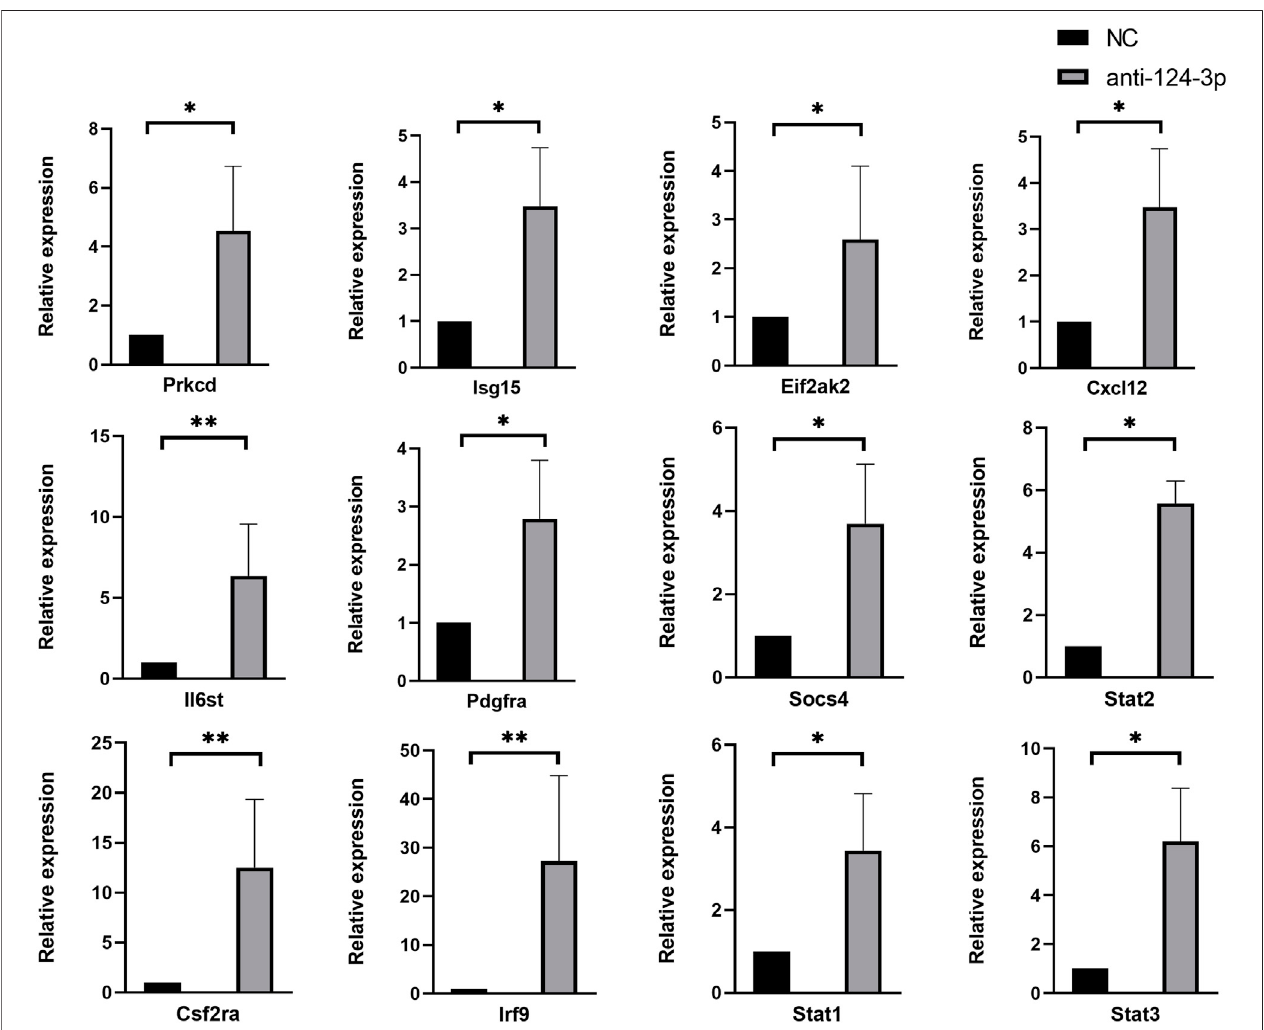
FIGURE 5 | Results of RT-qPCR showed the expression of candidate genes bewteen NC and anti-124 group, which exhibited a similar trend to the RNA-Seq results. Each RT-qPCR experiment was repeated three times with independently isolated RNA samples. Results were presented as mean ± standard deviation (anti- miR-124 group, miR-124-3p knockdown group; NC group, negative control group; * p < 0.05, ** p <